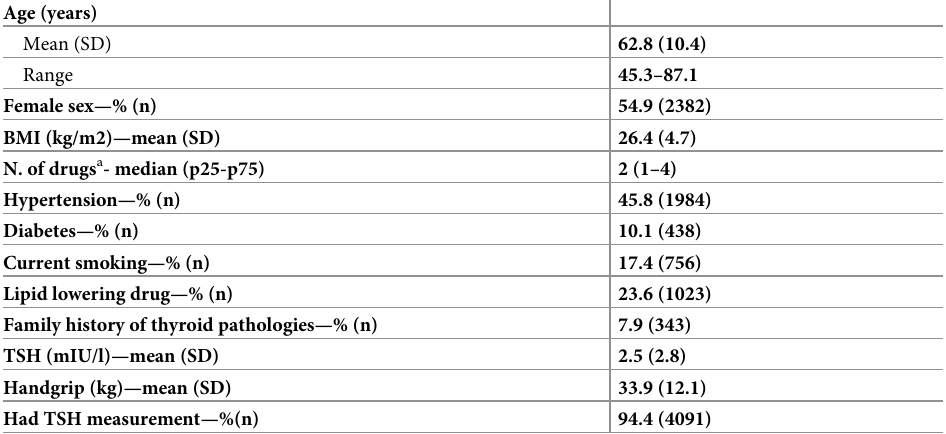
Table 1. Demographic characteristics at 10-years follow up for the participants who completed both 5-years and 10-years follow up (n = 4334).